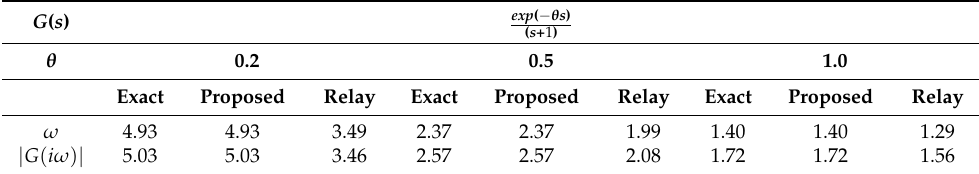
Table 2. Comparison of the proposed method and the relay feedback method [1] combined with the time delay [7] for the first-order plus time-delay process and PA set = − 3 π /4.